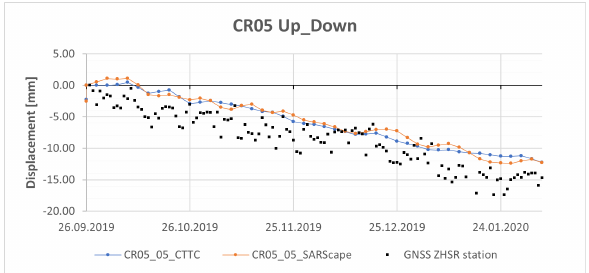
Figure 11. The CR5 vertical displacements determined by PSI and GNSS measurements